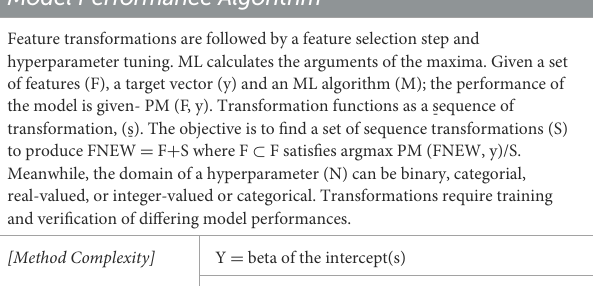
TABLE 2 Basic algorithm and method complexity. [Basic Algorithm] A Deep Science Machine—Basic Model Performance